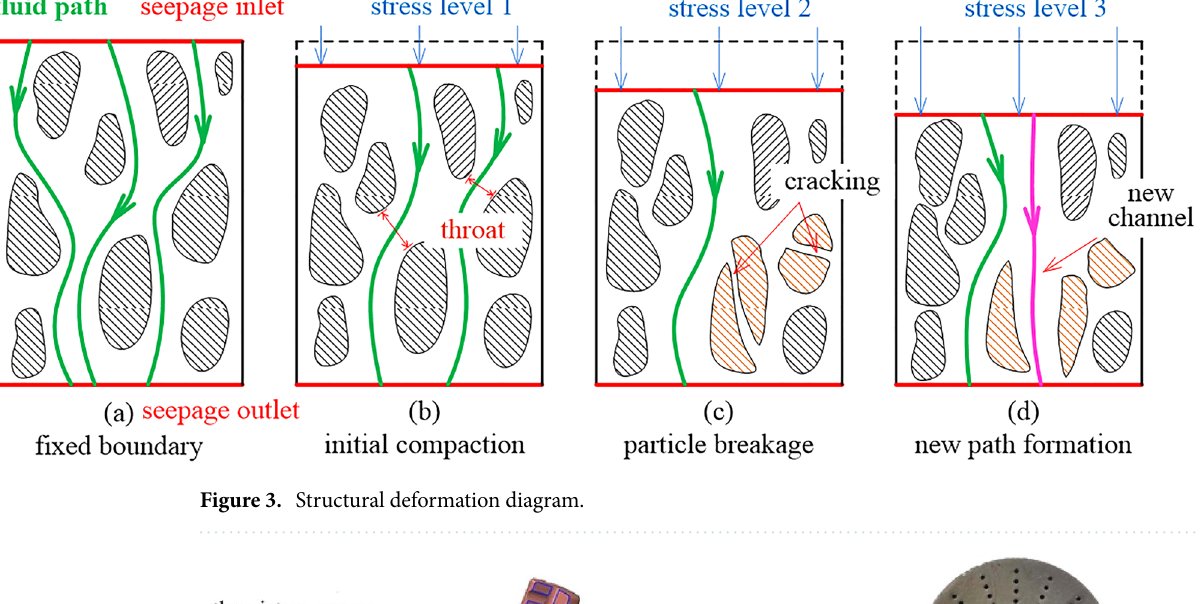
Figure 3. Structural deformation diagram.